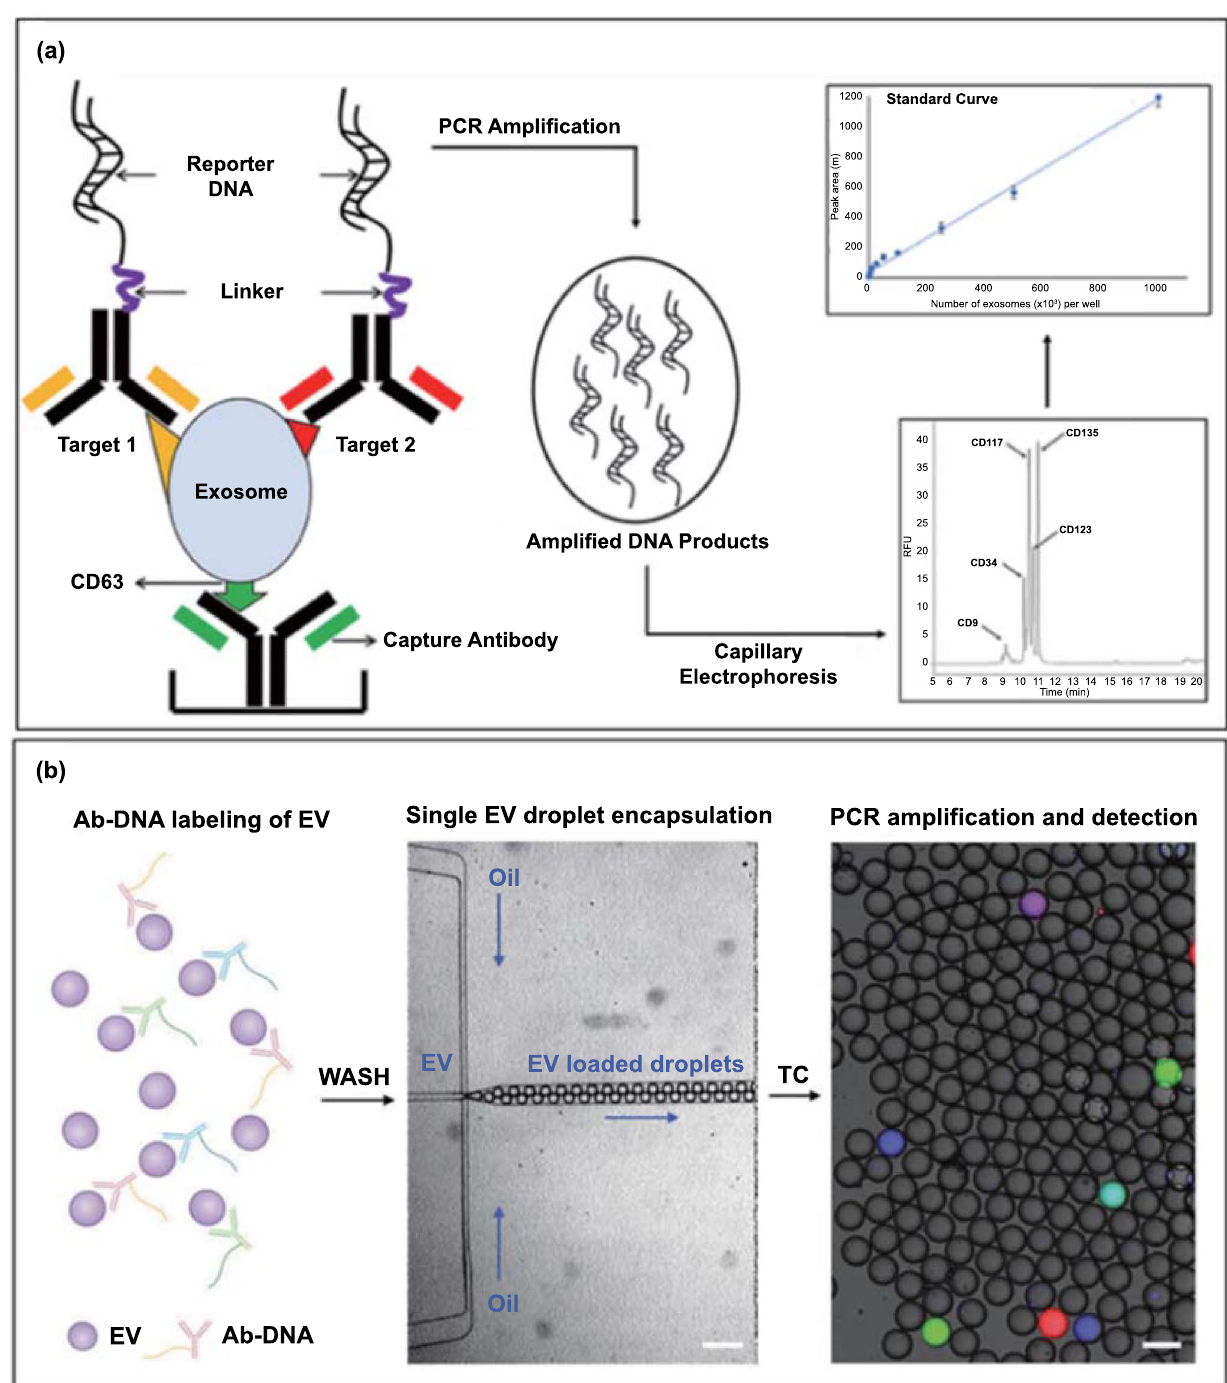
Fig. 9 a Schematic assay format of immuno-PCR assisted multiplex detection of membrane proteins on EVs using capillary electrophoresis. The standard curve of the peak area in an electropherogram vs number of exosomes per well for multiplex immuno-PCR (upper inset). The immuno-PCR peaks for the detection of CD9, CD34, CD117, CD123, and CD135 molecules (bottom inset). Adapted with permission from Ref. [155]. Copyright 2020 American Chemical Society. b The convergence of antibody-DNA labelling and digital PCR for EV multiplexing. Repro- duced with permission from Ref. [157]. Copyright 2020 John Wiley and